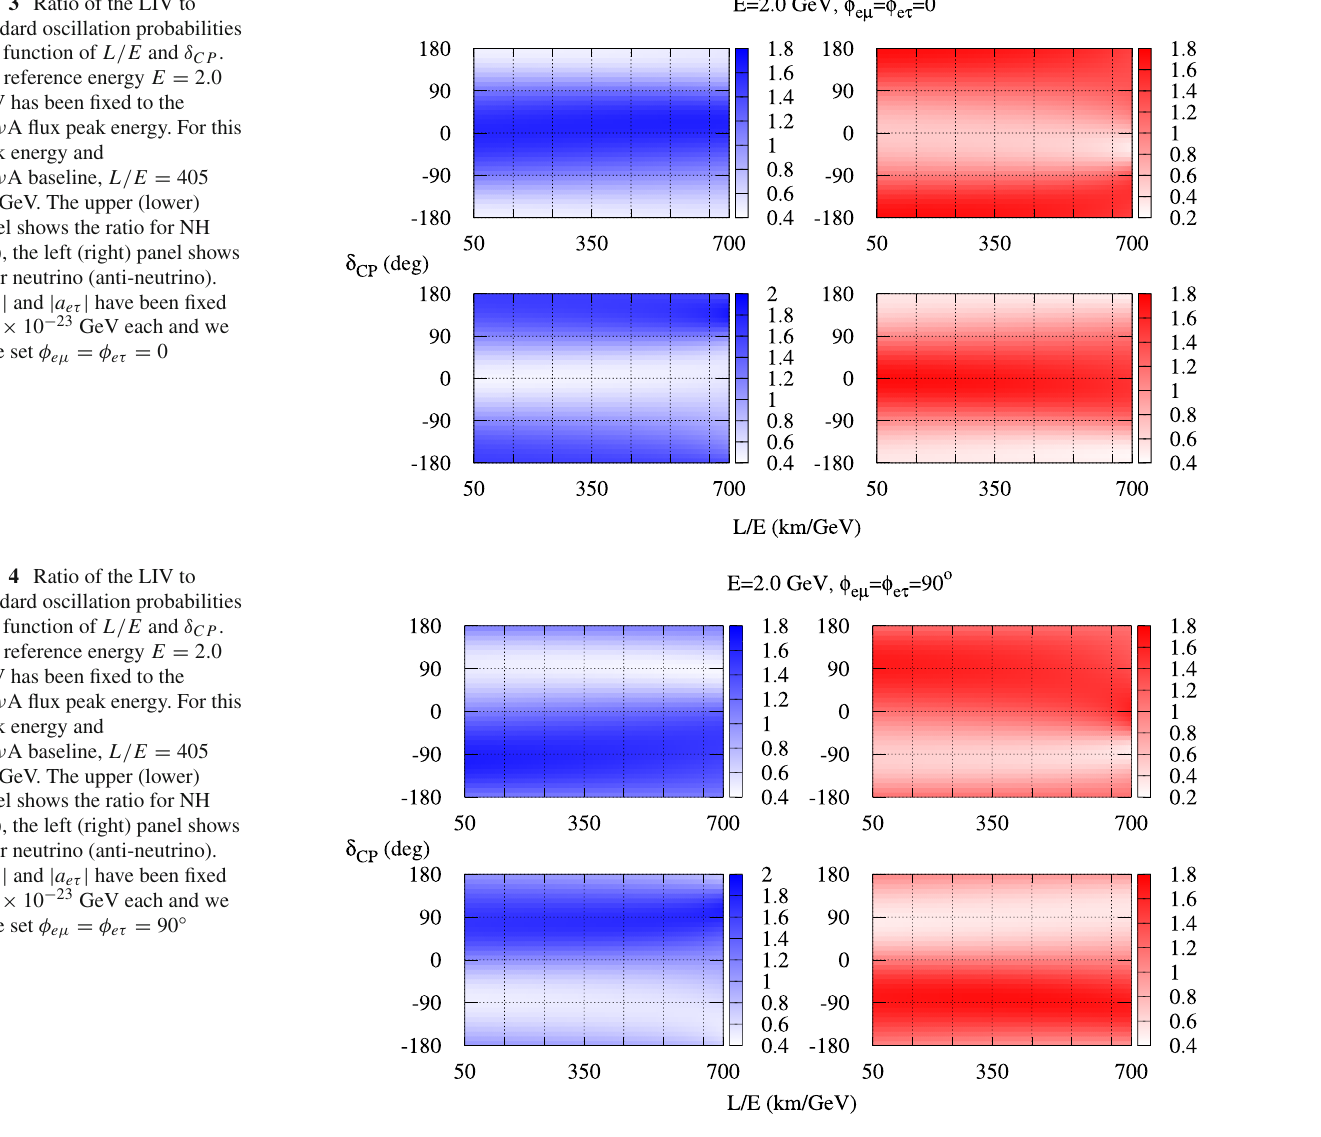
Fig. 3 Ratio of the LIV to standard oscillation probabilities as a function of L / E and δ CP .